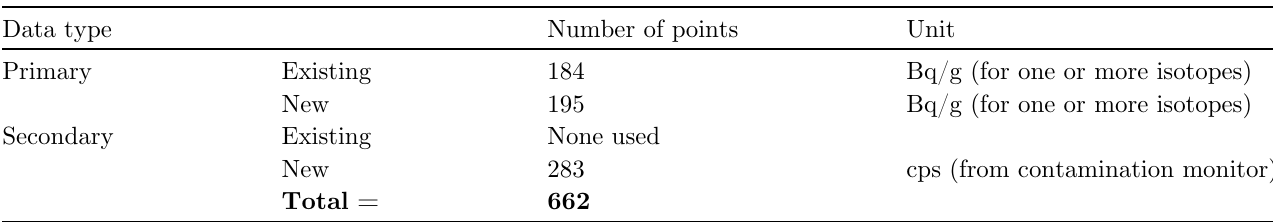
Table 1. Overview of the different types and corresponding amounts of data points, at the time of writing, in the un fi ltered dataset, gathered for constructing the 3D